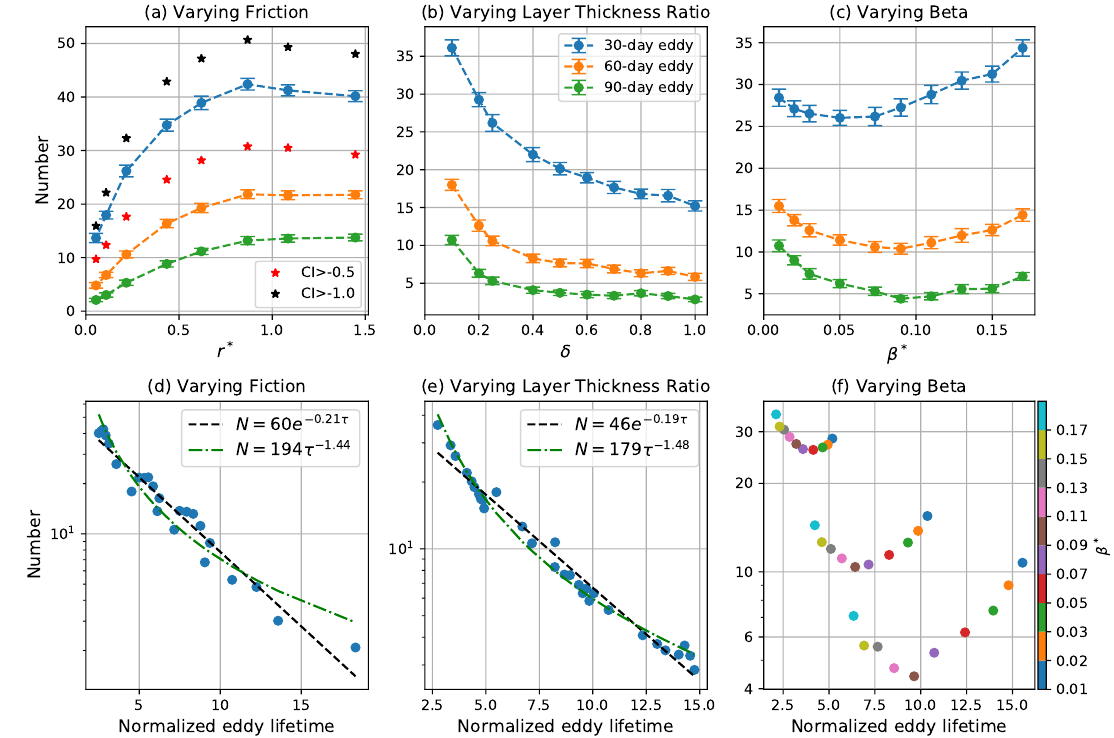
Figure 5. Number of coherent eddies in each time interval as a function of ( a ) r ∗ , ( b ) δ , and ( c ) β ∗ . Blue, orange, and green curves correspond to the mean of the number of 30-, 60-, and 90-day eddies, respectively. Error bars give two times the standard error of the mean over 100 time intervals. Red and black stars in the left panel indicate the mean for 30-day eddies detected by varying the CI threshold to − 0.5 and − 1.0, respectively. Average number of coherent eddies with lifetimes normalized by the eddy turnover time in each case for experiments varying ( d ) r ∗ , ( e ) δ , and ( f ) β ∗ . In ( d ) and ( e ), the black dashed line is an exponential fit N = N 0 e − λτ , and the green dash-dot line is a power law fit N = N 1 τ − α , where N is the number of coherent eddies, and τ is the normalized lifetime. In ( f ), different colored dots indicate the simulations with different β ∗